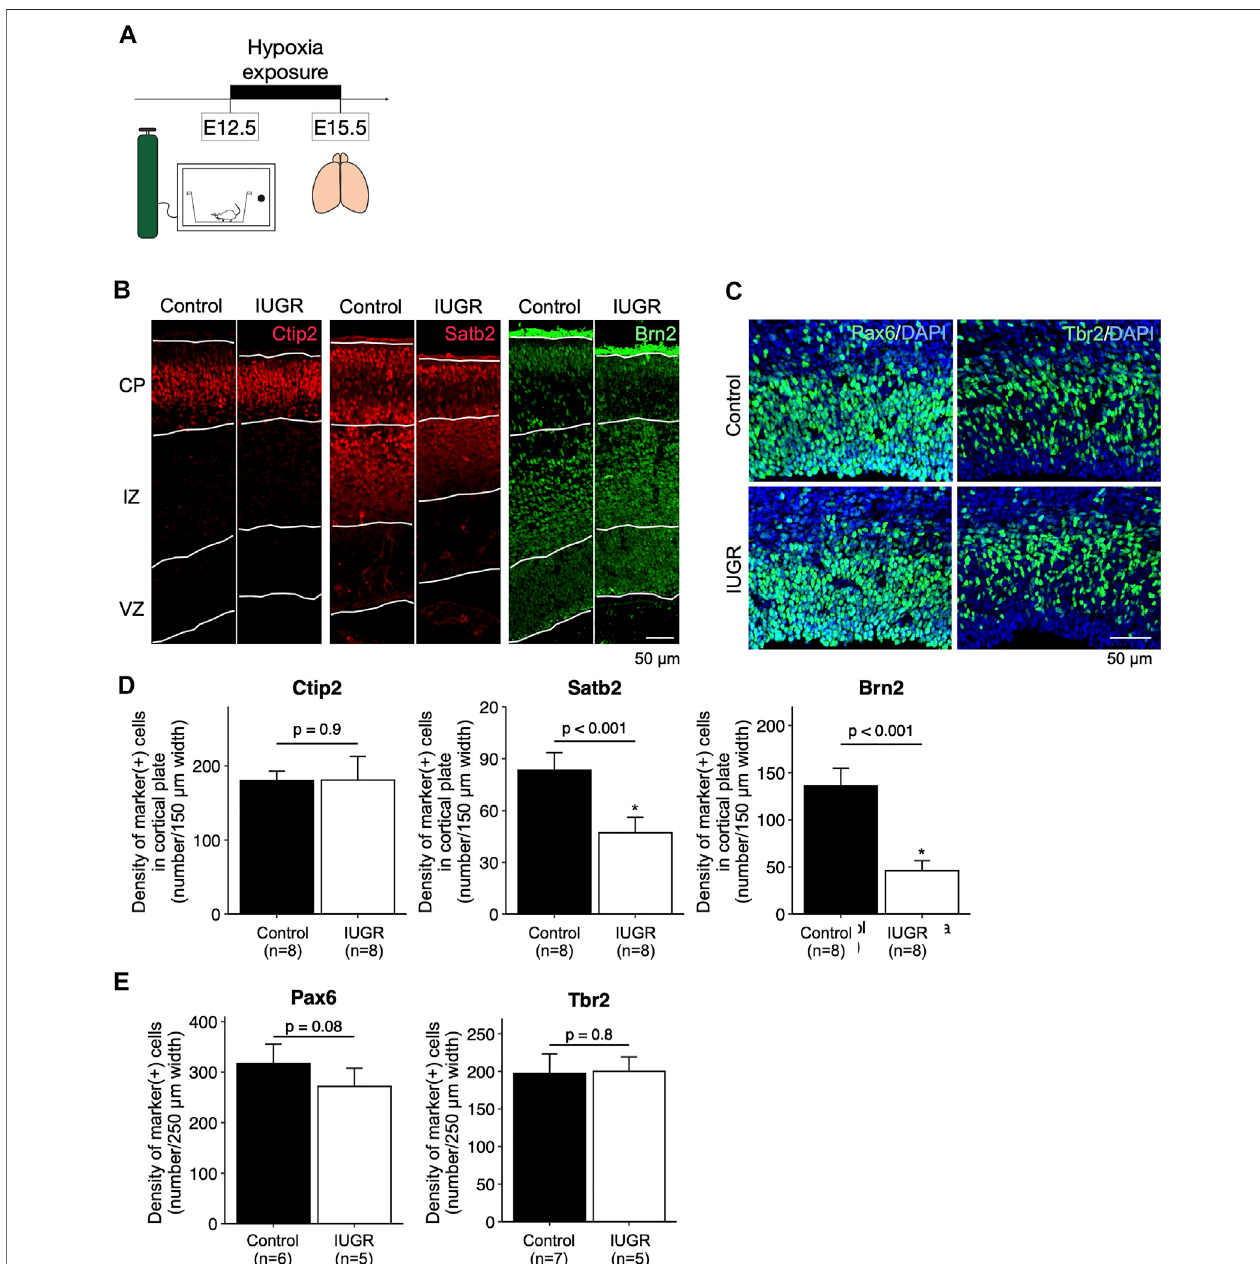
FIGURE 1 | Decreased cortical neurogenesis in the intrauterine growth restriction (IUGR) mouse fetal brain. (A) Schematic representation of the experimental design. (B) Immuno fl uorescence staining showing Ctip2-, Satb2-, and Brn2-positive cells in the cortical plate (CP), immediate zone (IZ), and ventricular zone (VZ) in the controlandtheIUGRgroups. (C) Immuno fl uorescencestainingshowingPax6-andTbr2-positivecellsintheVZinthecontrolandIUGRgroups.Thetissuesectionswere counterstained with DAPI (not shown) to visualize all cells in a given tissue section. (D) Quanti fi cation of the densities of cells expressing the indicated markers as shown in Panel B. (E) Quanti fi cation of the densities of cells expressing the indicated markers as shown in Panel C.